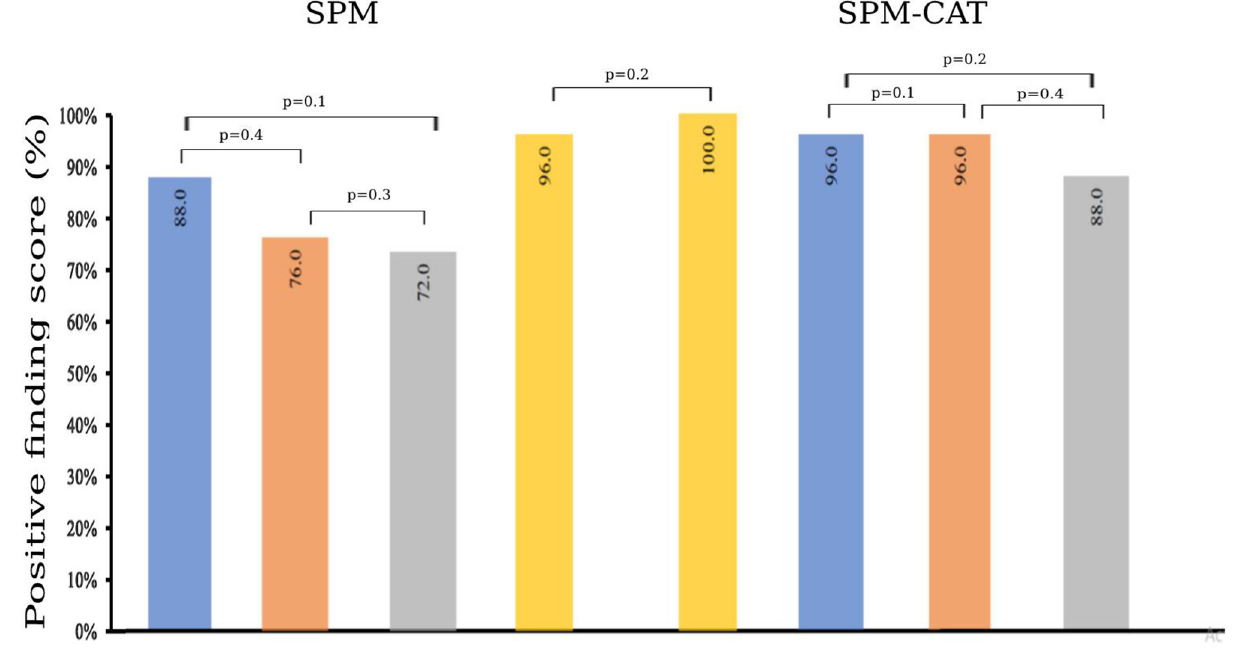
Frontiers in Neurology |